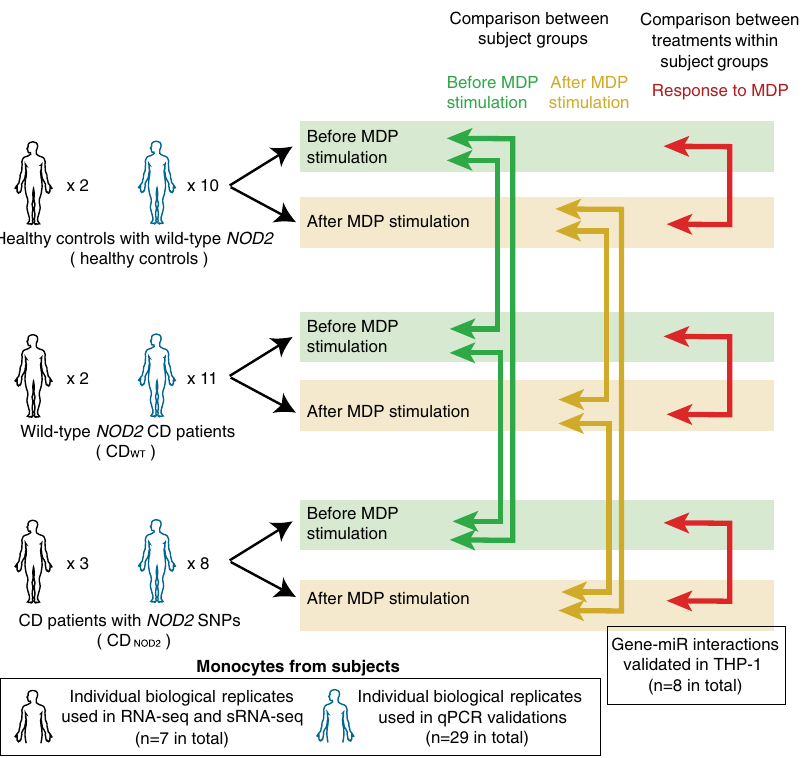
Fig. 1 Overview of cohorts and differential expression analyses. Monocytes were derived from three subject groups: healthy controls, CD patients with WT NOD2 genotypes (CD WT ), and CD patients with loss-of-function NOD2 genotypes (CD NOD2 ). Monocytes were analyzed by RNA-Seq and small RNA-Seq ( black body outlines, number of tested individuals is indicated), and selected genes and miRNAs were validated by qPCR in a validation cohort ( blue body outlines, number of tested individuals is indicated). We analyzed the difference between subject groups, before and after MDP stimulation ( green and yellow arrows , shown in Figs. 2,3), and the response to MDP stimulation within each group ( red arrows , shown in Fig.